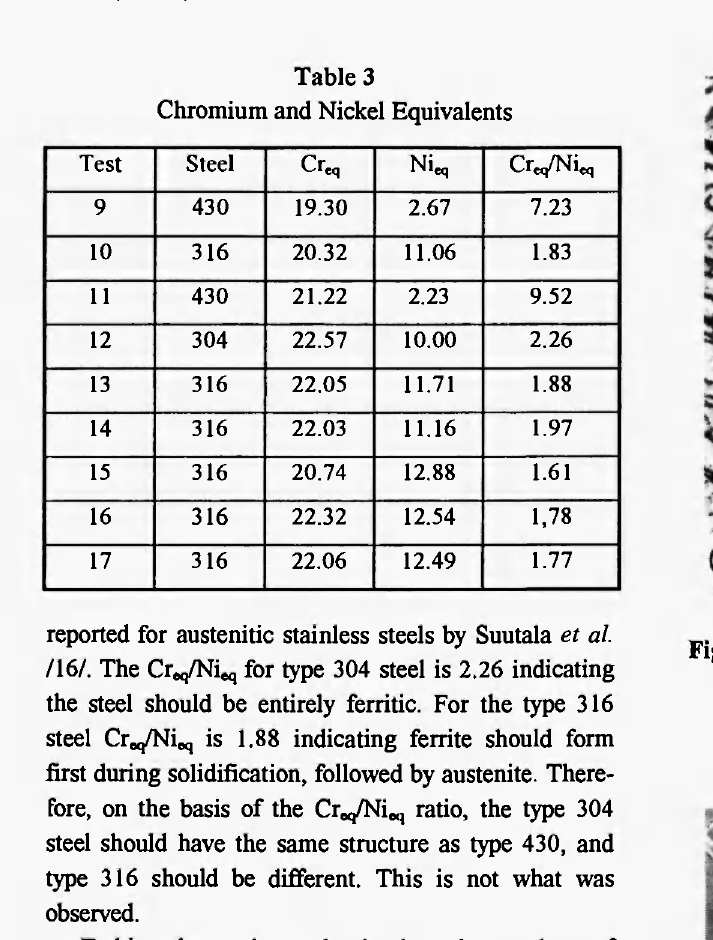
Etched surface of type 304 stainless steel (Test 12) showing light areas (austenite) separated by dark bands (ferrite).